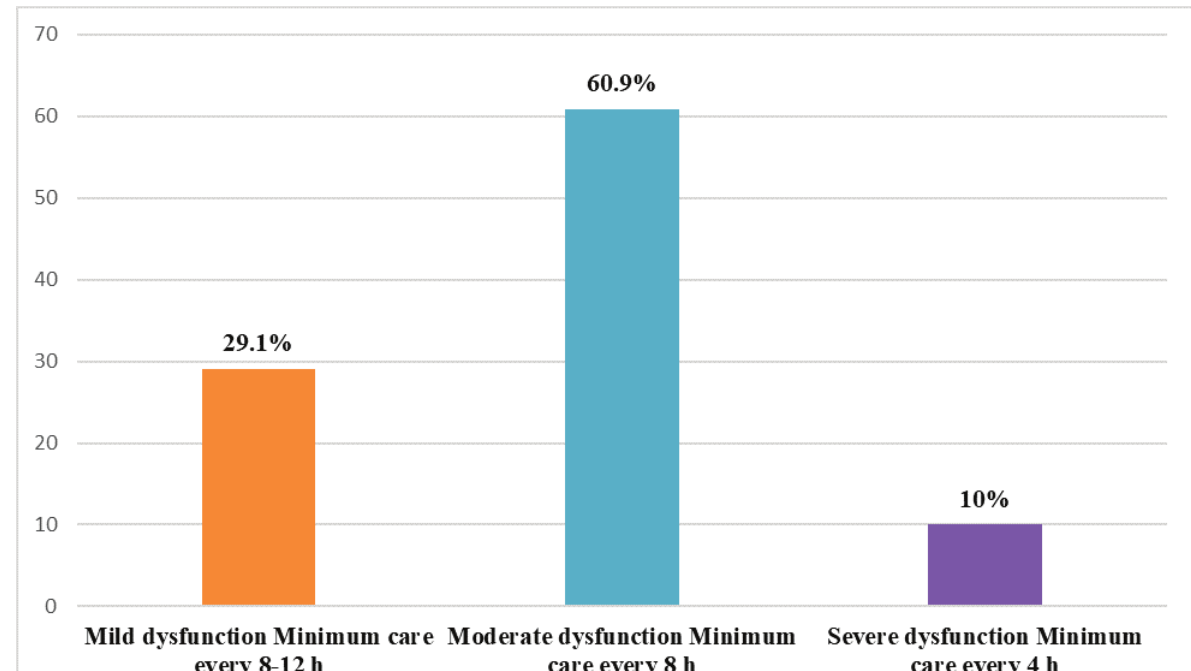
Figure-I: Dysfunction of Beck oral assessment scale